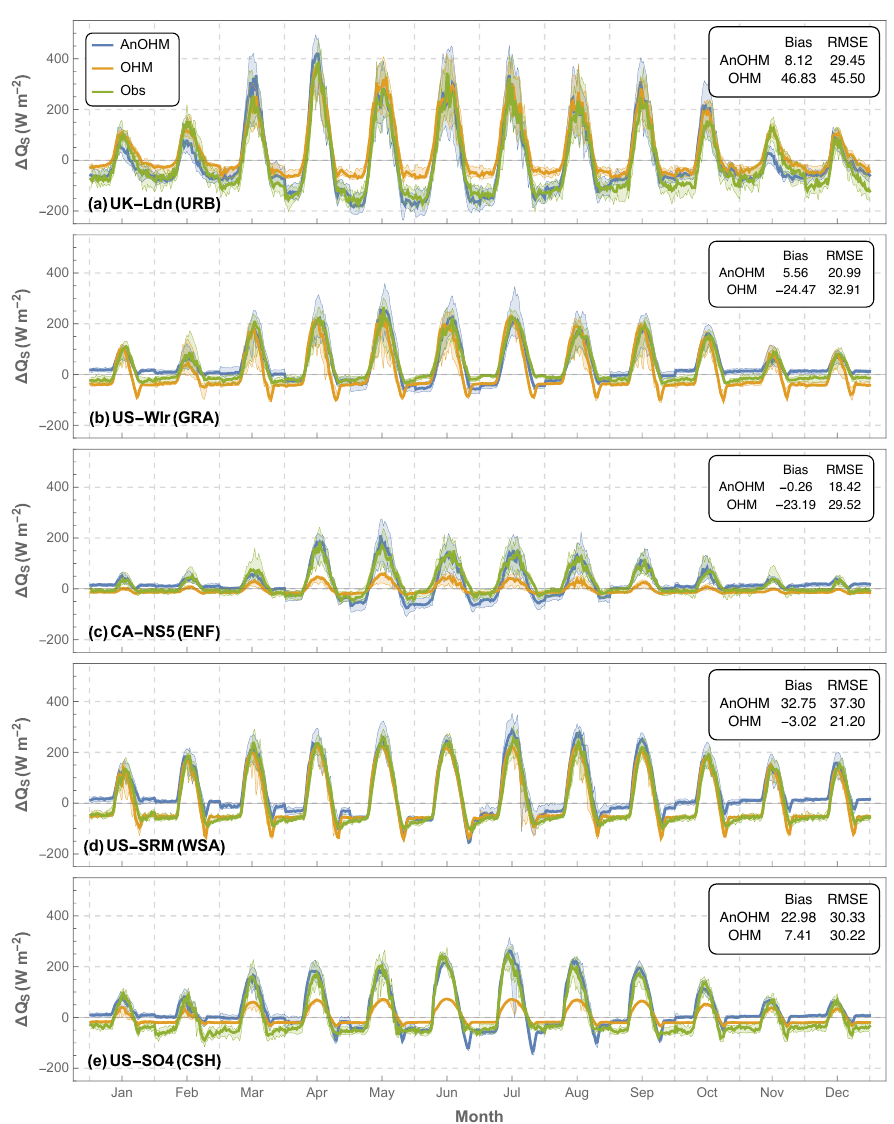
Figure 6. Monthly median (line) diurnal cycles and interquartile range (shaded) values of (cid:49)Q S for AnOHM predictions (blue), OHM predictions (orange) and observations (green) at (a) UK-Ldn (URB), (b) US-Wlr (GRA), (c) CA-NS5 (ENF), (d) US-SRM (WSA), and (e) US-SO4 (CSH) (see Table 2 for site information). Statistics include average bias and RMSE (Wm − 2 ) . The OHM coefficients a 1 , a 2 , and a 3 used for different land covers are: 0.553, 0.303, and − 37.6 at the urban site (UK-Ldn) (Ward et al., 2016), 0.32, 0.54, and − 27.4 at the grass-covered sites (US-Wlr and US-SRM) (Grimmond and Oke, 1999), and 0.11, 0.11, and − 12.3 at the forest-covered sites (CA-NS5 and US-SO4) (Grimmond and Oke,